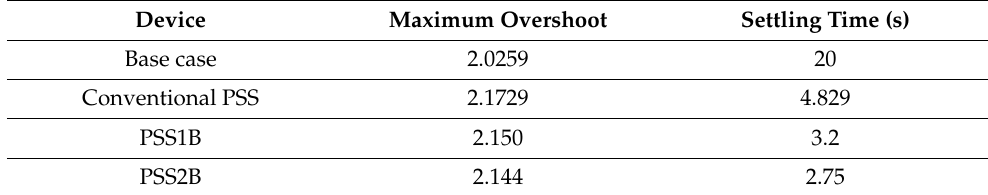
Table 16. Maximum overshoot and settling time of rotor angle at heavy loading.